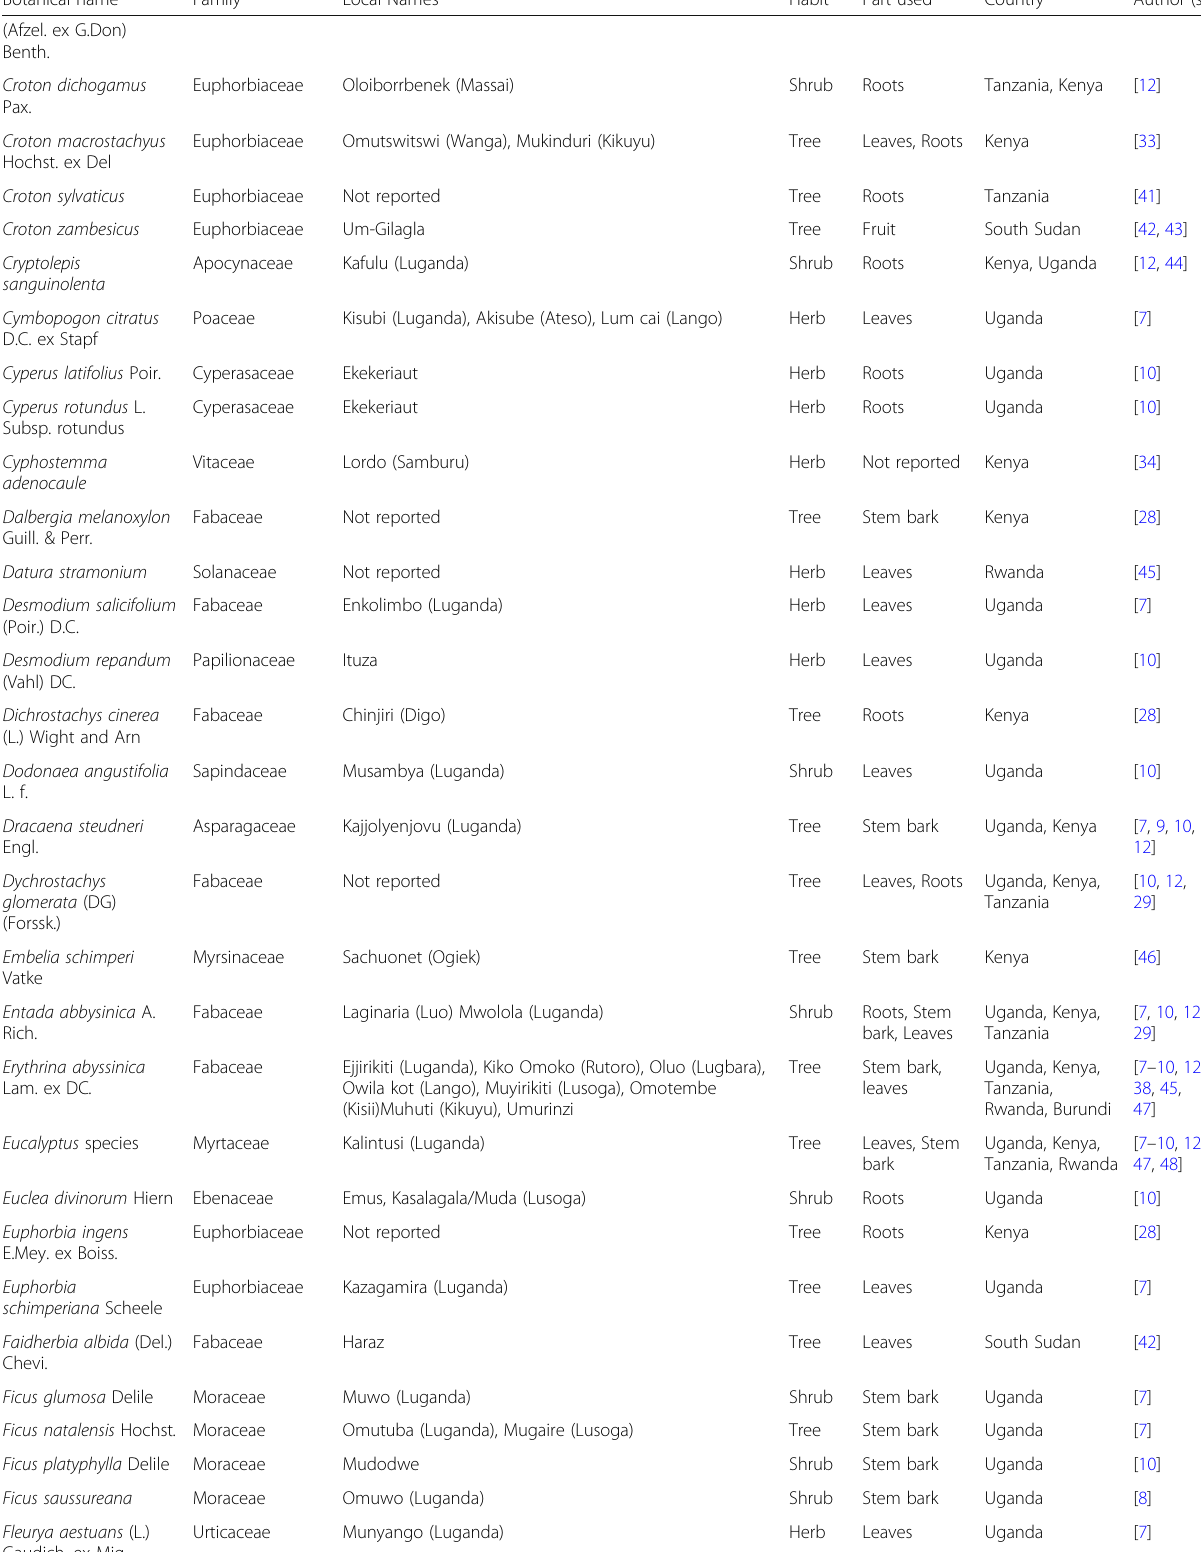
Table 1 Medicinal plants used in treatment of symptoms of TB in East Africa (Continued) Botanical name (Afzel. ex G.Don)